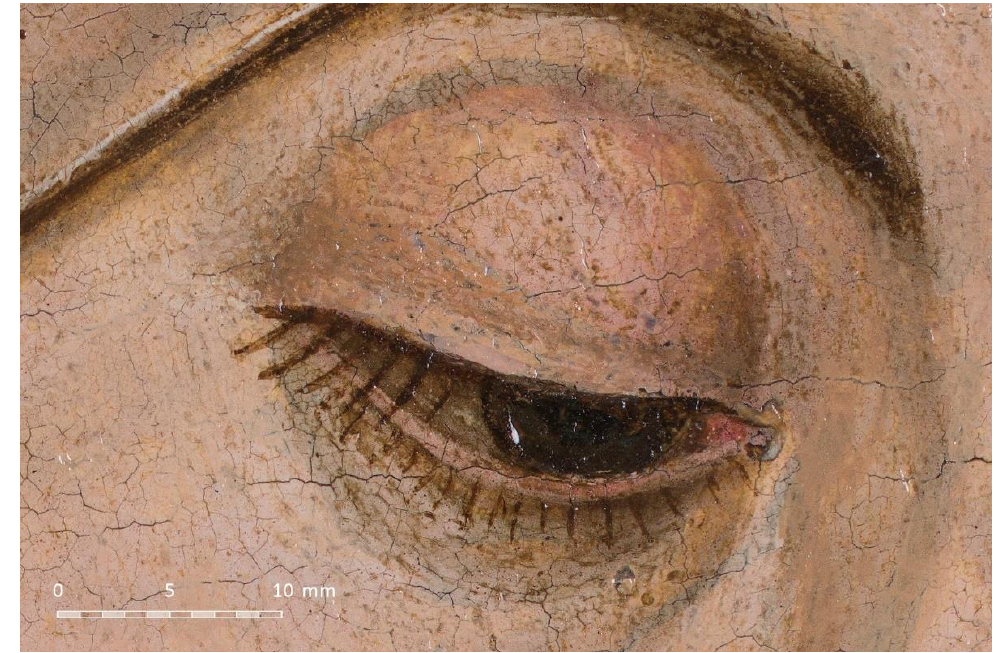
Figure 17. Fragment of the resulting gigapixel image.